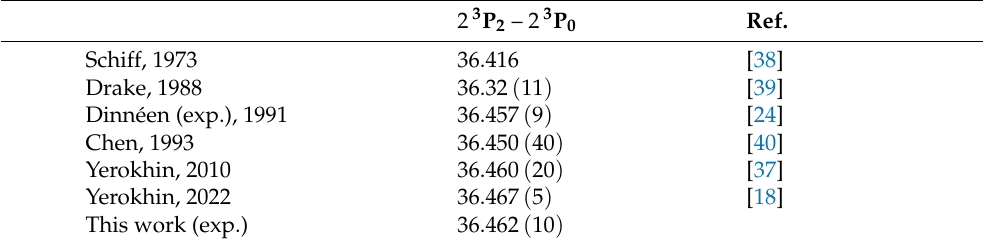
Table 1. Preliminary result for the 2 3 P 2 – 2 3 P 0 fine-structure splitting in 11 B 3+ . Numbers are given in cm − 1 , and 1 σ uncertainty is indicated in parentheses if available. The final analysis is expected to provide an even more accurate